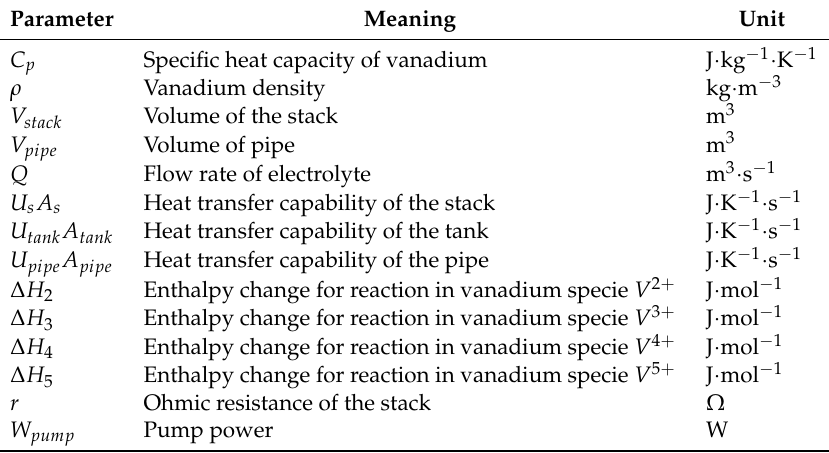
Table 9. Parameters of the thermal